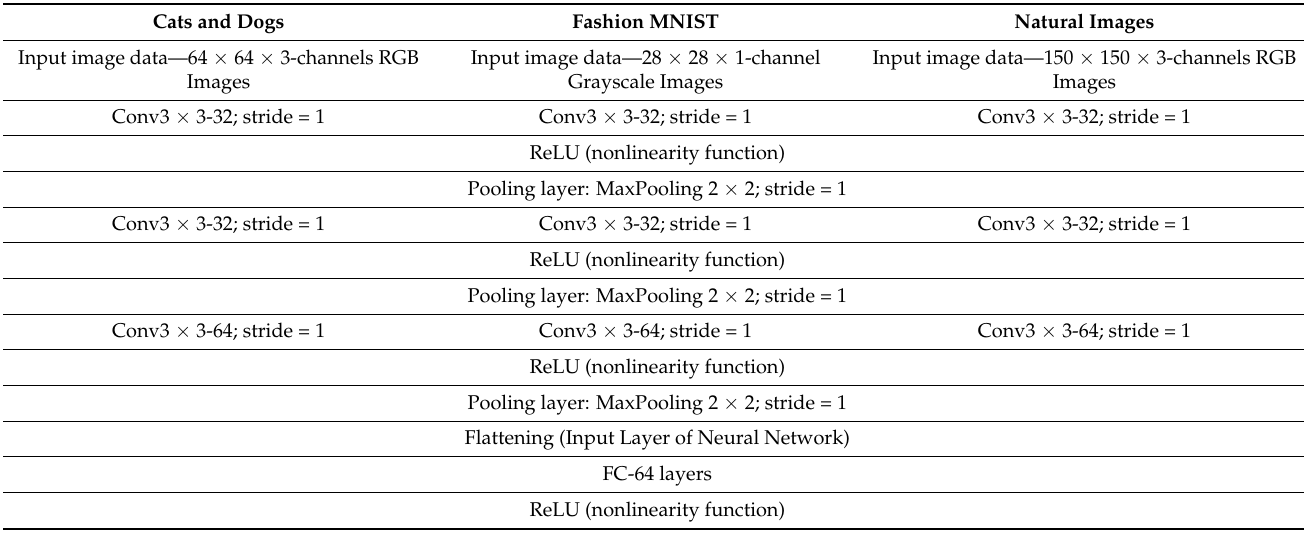
Table 4. Configuration summary of the simple CNN denoted as s